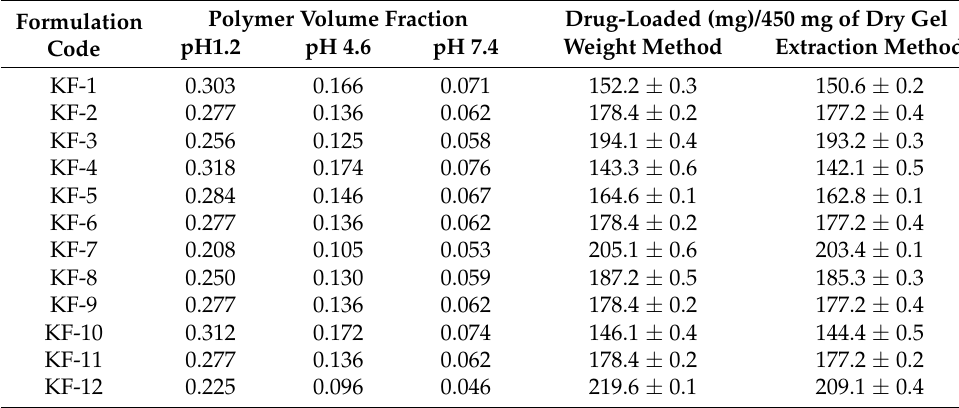
Table 2. Polymer volume fraction and drug loading of CS/CP/PVAcPAa hydrogels.